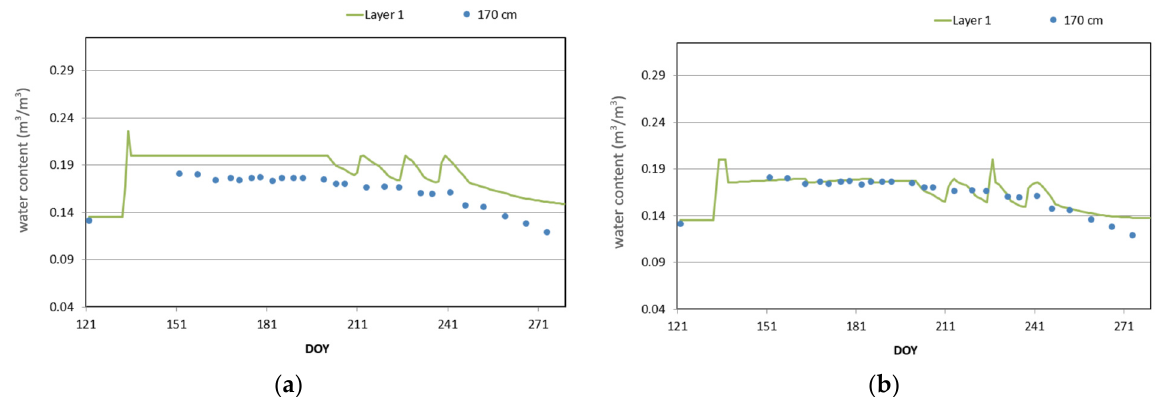
Figure 7. Simulation (green) based on laboratory measurement of field capacity (FC) for layer 1 (lower layer) of the FT4 plot ( a ) and simulation with adjusted field capacity ( b ) based on observed neutron probe data (blue circles).